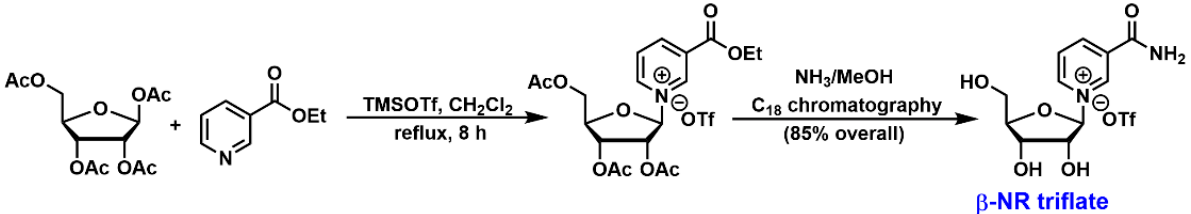
Figure 3. Synthetic scheme of β -NR triflate developed by Sauve et al. [39,55].